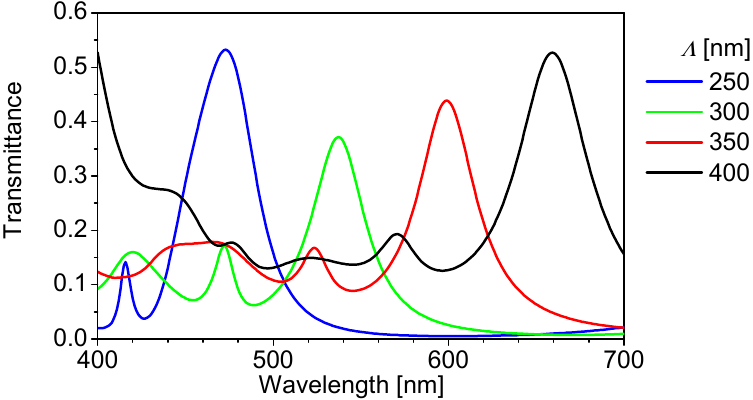
Figure 4. Calculated transmittance spectra penetrating a Si substrate for several grating periods. a / Λ is fixed to be 0.8.